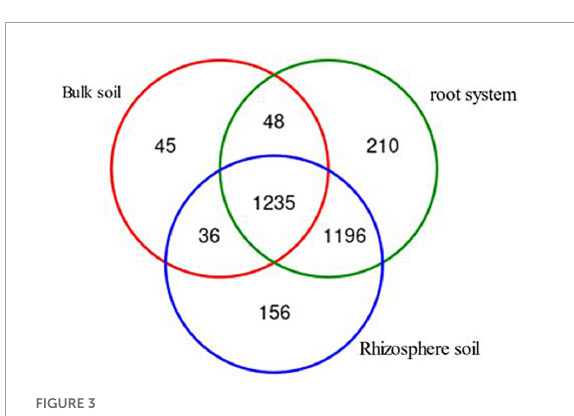
FIGURE3 Venn diagram of the arbuscular mycorrhizal fungi (AMF) community based on the operational taxonomic units (OTUs) level in different clones of Chinese fir plantations at different sampling